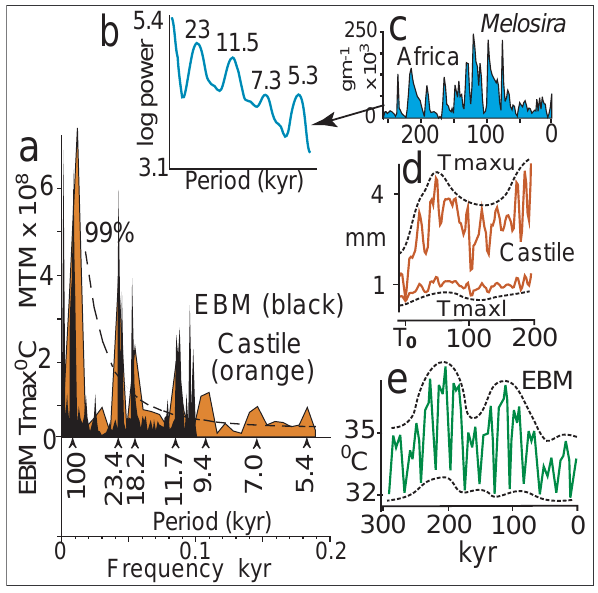
Fig. 3. Rectified series and their spectra. (a) Castile spec- trum (brown) for series in Fig. 2 compared with spectrum for EBM T max series (solid black, from Crowley et al., 1992). Con- fidence line applies to Castile spectrum only. Castile spec- trum, MTM, resol.=1 window=1, N =1620). (b) Spectrum for African Melosira dust record with precession cycle and harmon- ics. (c) African Melosira dust series with ∼ 5 prominent, sharp, amplitude-modulated precession cycles comprising a ∼ 100kyr os- cillation. Note secondary maxima with lagged and sloped shoul- ders – (b) and (c) from Pokras and Mix, 1987. (d) Castile series depicted by transparent traces in Fig. 2. Note amplitude-modulated precession and semi-precession cycles, and secondary lagged max- ima with sloped shoulders. (e) EBM-generated T max series for Pangea, with secondary maxima, amplitude-modulated precession cycles, and covariant upper and lower bounds (from Crowley et al.,